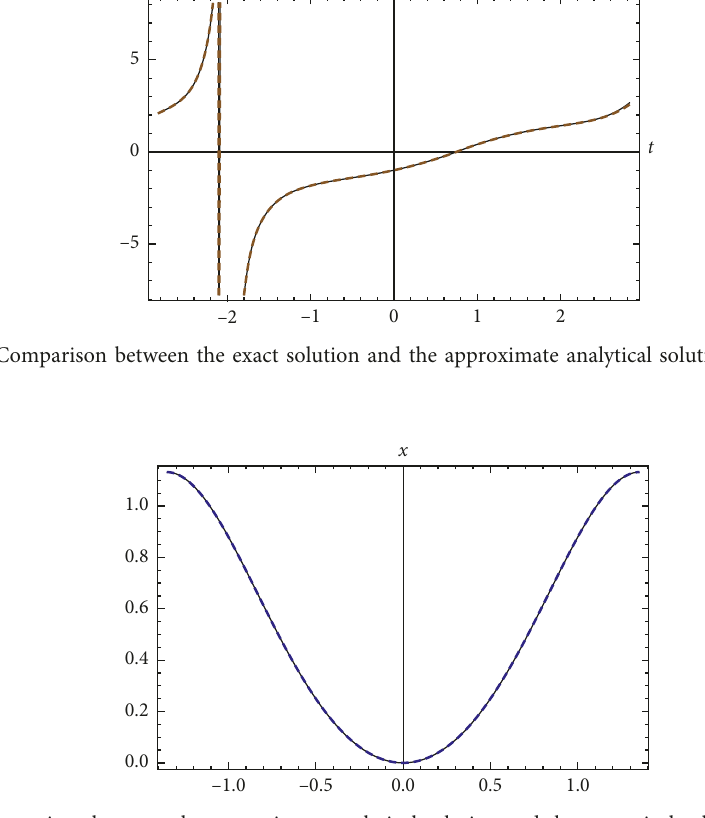
Figure 5: Comparison between the approximate analytical solution and the numerical solution for Example